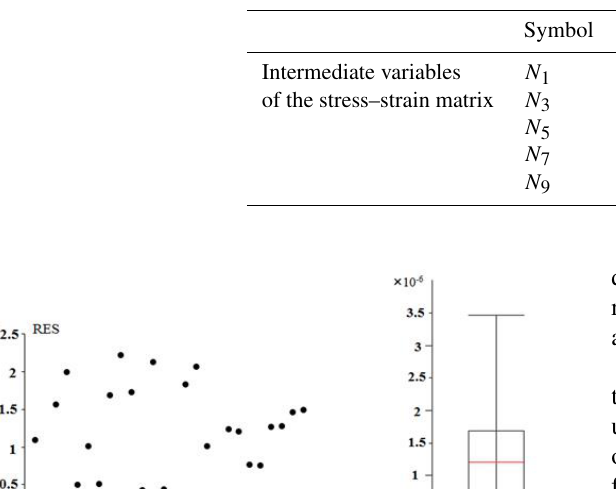
Table 9. Intermediate variables in stress inversion calculation.